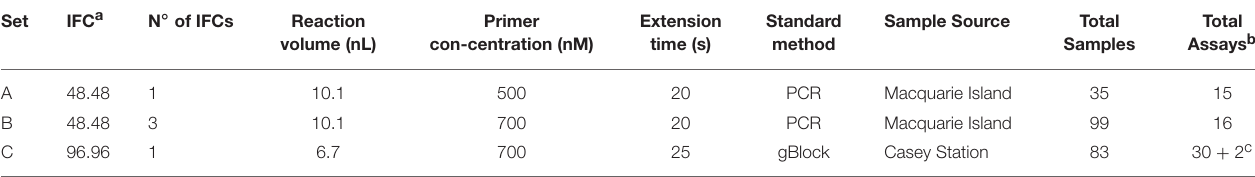
TABLE 2 | MFQPCR assay conditions varied across the three experimental